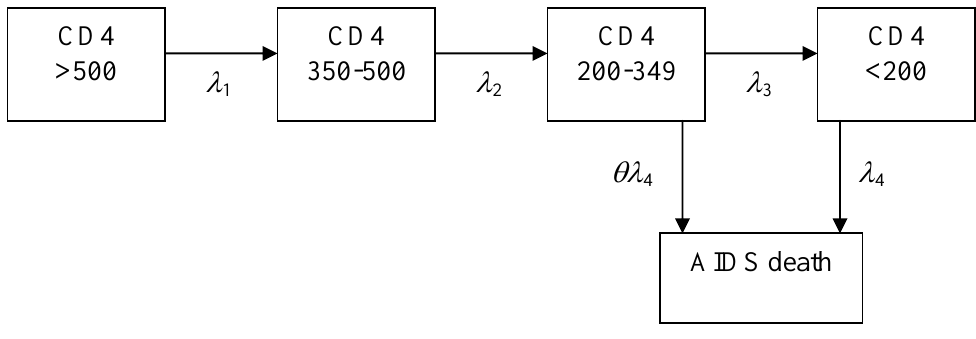
Figure 1: Multi-state model of decline in CD4 count in HIV-infected